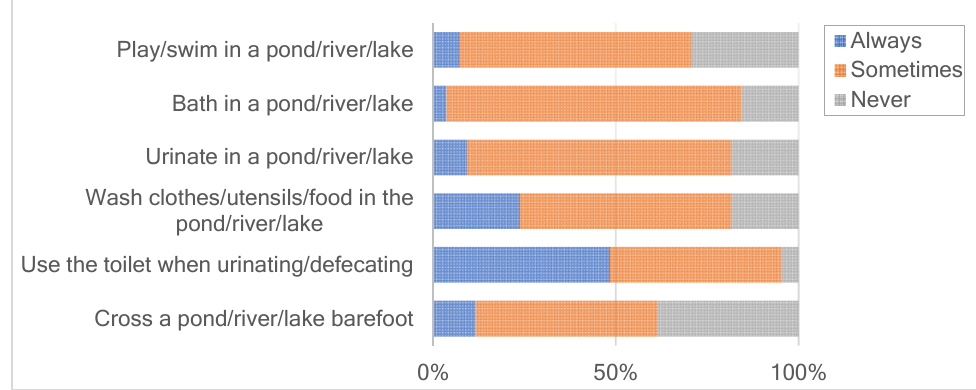
Figure 3. Participants’ practices related to schistosomiasis.